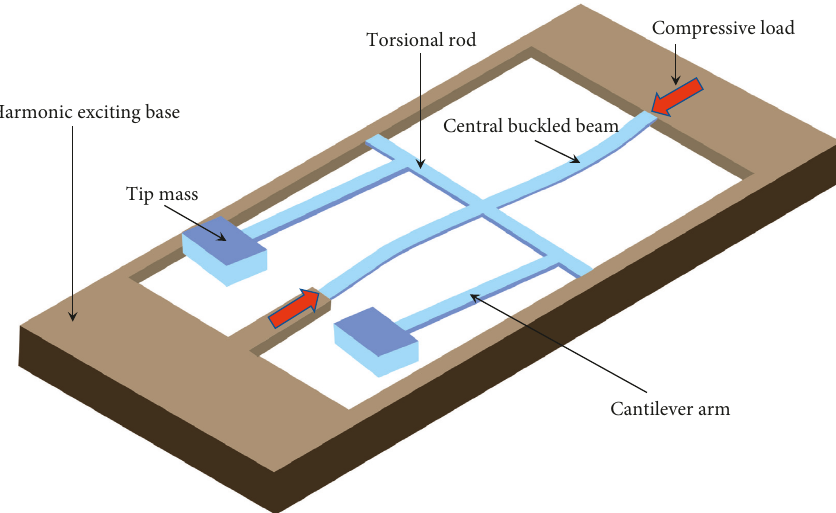
Figure 1: The schematic model of the buckled, bistable vibration energy